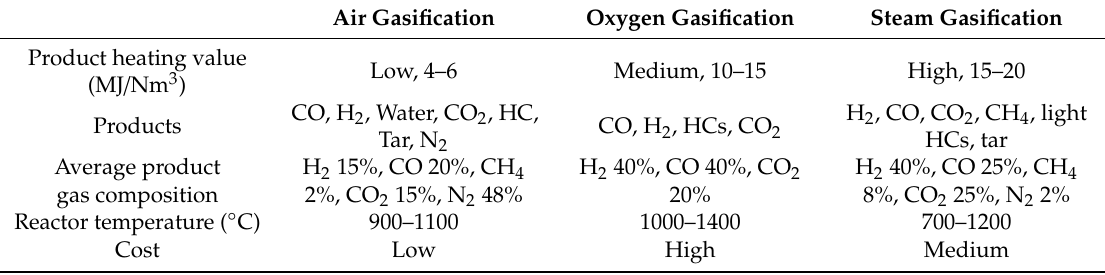
Table 1. Comparison between biomass gasification processes